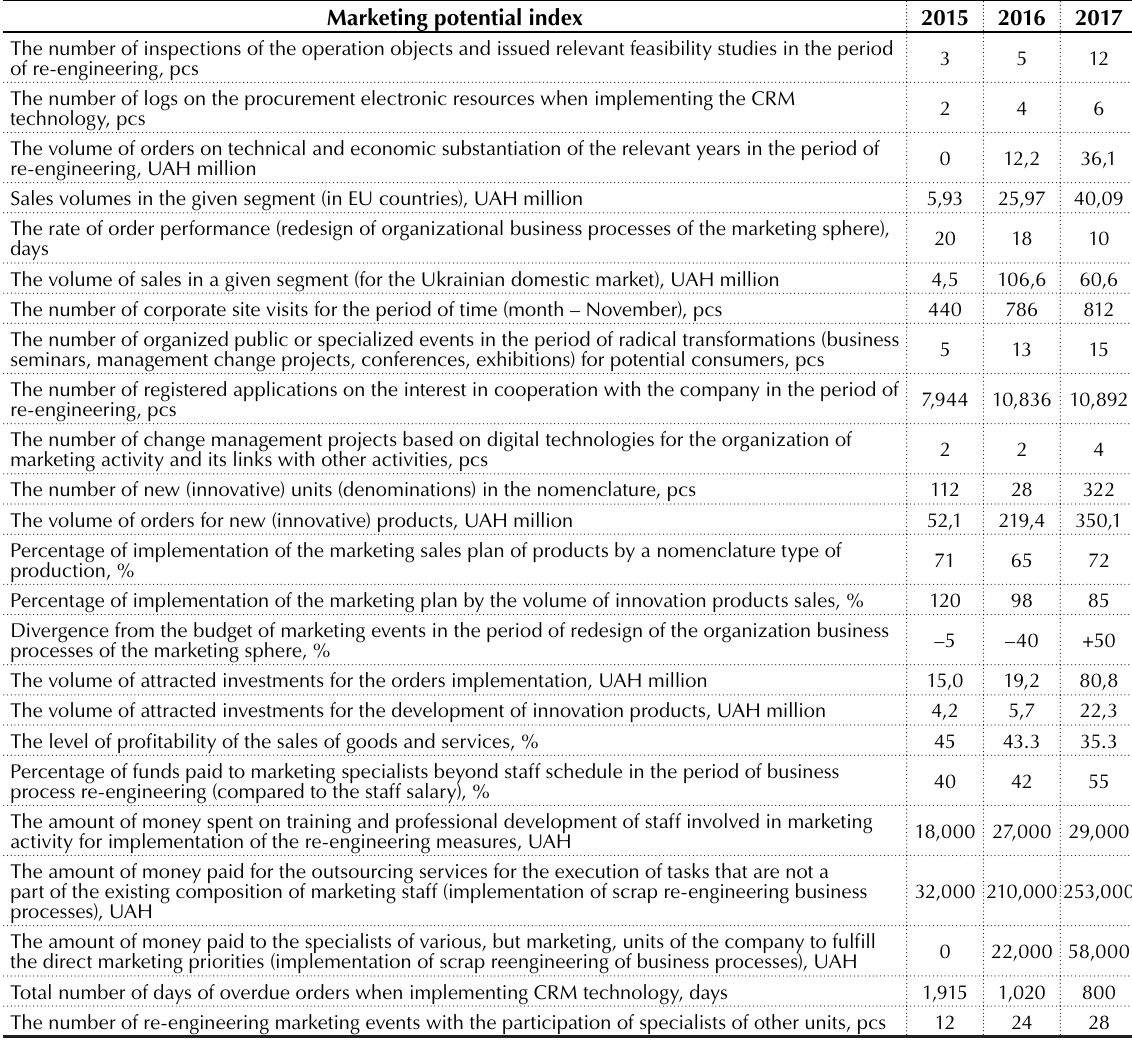
Table 2. Incoming information on the estimation of the marketing potential of JSC Sumy Plant Nasosenergomash in the period of business processes’ re-engineering Marketing potential